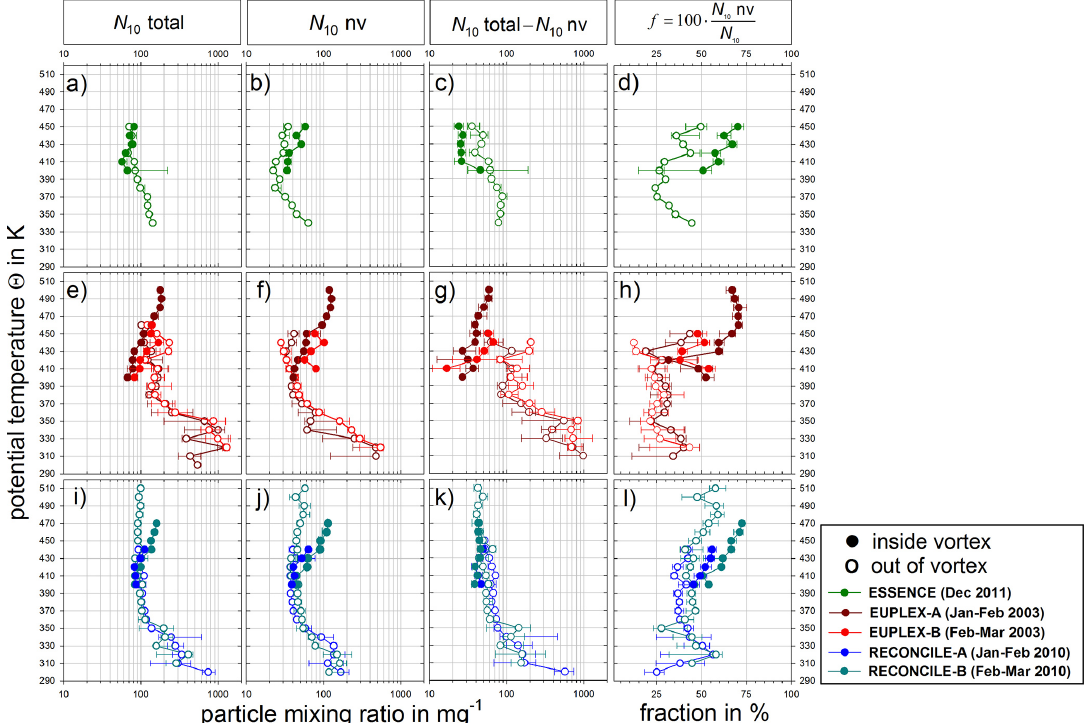
Figure 5. Median vertical profiles of particle mixing ratios with 25th and 75th percentiles (bars) as function of potential temperature (cid:50) . If whiskers are not visible the percentile range is covered by the size of data points. Data are attributed to either originate from inside (dots) or outside the vortex (circles) by using the (cid:49) N 2 O vortex index ξ vi (cf. Sect. 2). Aerosol mixing ratios N 10 , (left column), N 10 nv (mid-left column), mixing ratio difference N 10 – N 10 nv (mid-right column) and resulting fraction f of refractory particles (right column). (a) to (d) from ESSenCe (i.e., the mission conducted the earliest in the winter season); (e) to (h) data from EUPLEX; (i) to (l) results from